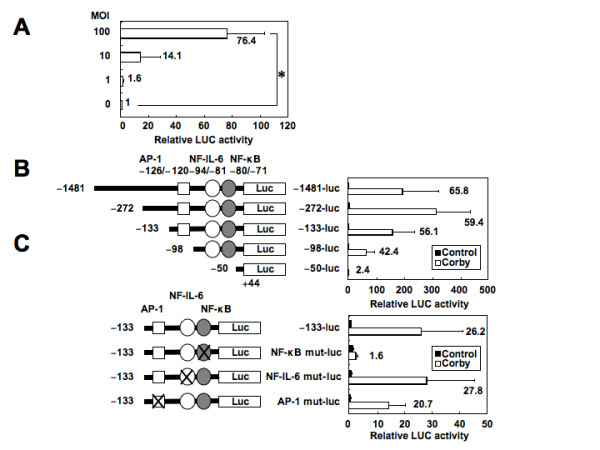
L. pneumophila infection activates IL-8 promoter in Jurkat cells. (A) Jurkat cells transfected with -1481-luc were infected with L. pneumophila Corby at the indicated MOI values for 6 h. The luciferase activities were expressed relative to cells transfected with -1481-luc followed by mock-infection. *, P < 0.01, as determined by the Student t test. (B) Reporter assay using plasmid DNA containing serial deletions in 5'-flanking region of the IL-8 gene. (Left) Schematic representation of the IL-8 reporter constructs, demonstrating locations of several known binding sites for transcription factors. (Right) The indicated luciferase reporter constructs were transfected into Jurkat cells, and the cells were subsequently infected with Corby strain (MOI of 100) for 6 h. The activities are expressed relative to that of cells transfected with -50-luc followed by mock-infection, which was defined as 1. The numbers on the bars depict fold induction relative to the basal level measured in uninfected cells. (C) Relative importance of AP-1, NF-IL-6, and NF-κB binding sites in IL-8 promoter. Wild-type and mutated plasmids were transfected into Jurkat cells. The transfected cells were infected without or with Corby. The activities are expressed relative to that of cells transfected with -133-luc followed by mock-infection, which was defined as 1. Luciferase activities were normalized based on the Renilla luciferase activity from phRL-TK. The numbers on the bars depict fold induction relative to the basal level measured in uninfected cells. LUC, luciferase. Graph data are mean ± SD values of three experiments.